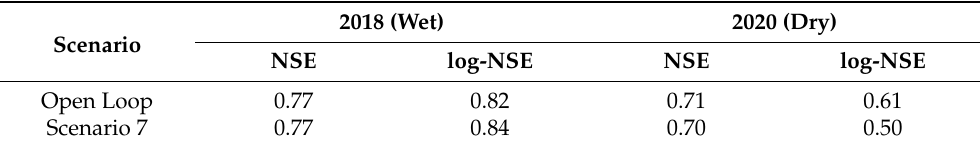
Table 4. Changes to streamflow modeling performance in terms of NSE and log-NSE for the open loop scenario and Scenario 7 in the years 2018 and